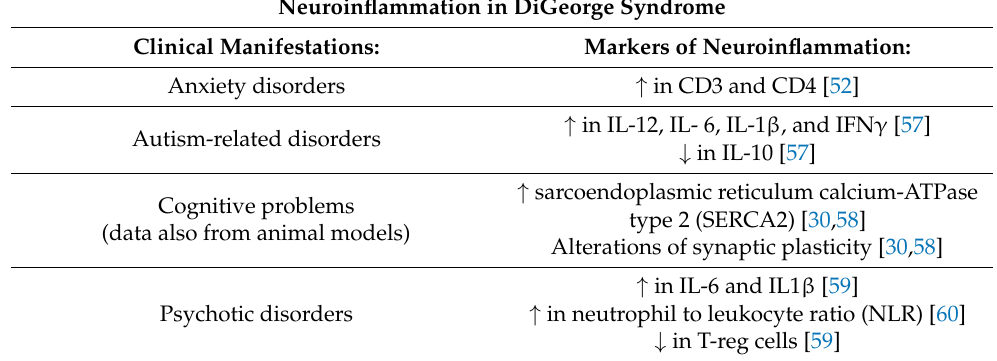
Table 2. Relations between the neuropsychological disorders and markers of neuroinflammations in patients affected by DGS. ↑ indicates elevation. ↓ indicates